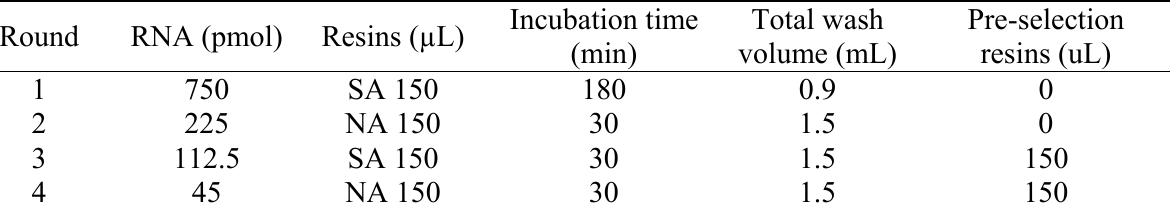
Table 3. Summary of the SELEX